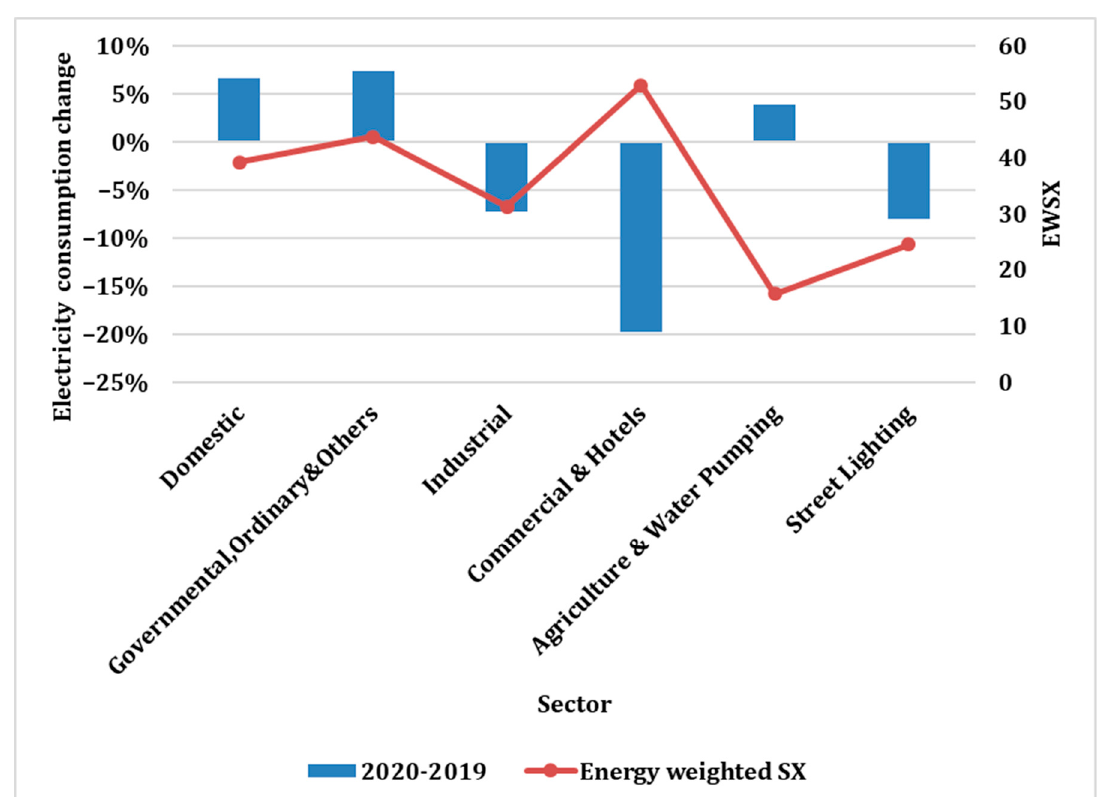
Figure 8. Change in electricity consumption by sector for 2019 and 2020 with energy-weighted strin- gency index.